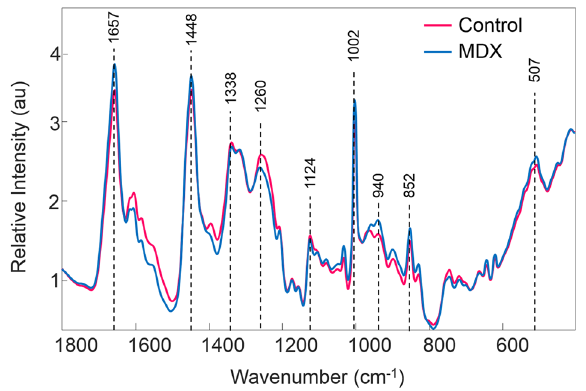
Figure 2. Mean preprocessed Raman spectra collected from the two classes of dried mice blood serum. The mean preprocessed spectrum of all control mice blood serum samples is represented by the pink line, whereas the mean preprocessed spectrum of all mdx mice blood serum samples is represented by the blue